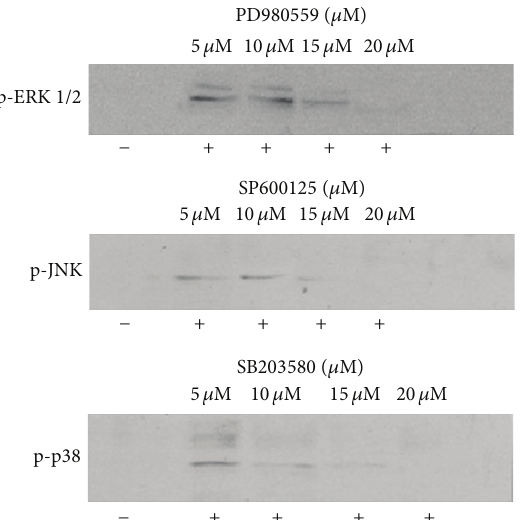
Figure 8: Inhibitors of ERK1/2 PD980559, JNK SP600125, and p38 SB203580 inhibited the expression of each of the MAPKs in the HEp-2 cell line treated cell 1 hour before infection and maintained for 120 minutes after the test. The experiments were performed by adding inhibitor at concentrations from 5 𝜇 M to 20 𝜇 M (1.3 to 5.2 𝜇 L, resp.). Protein levels were detected by Western blot. Immunoblotting was done with monoclonal antibody specific for protein phosphorylated technique that was described in “Materials and Methods”. The extracted proteins ( − ) represent HEp-2 cells without infecting and the proteins (+) refer to cells infected with the HPIV-1. The tests were performed in